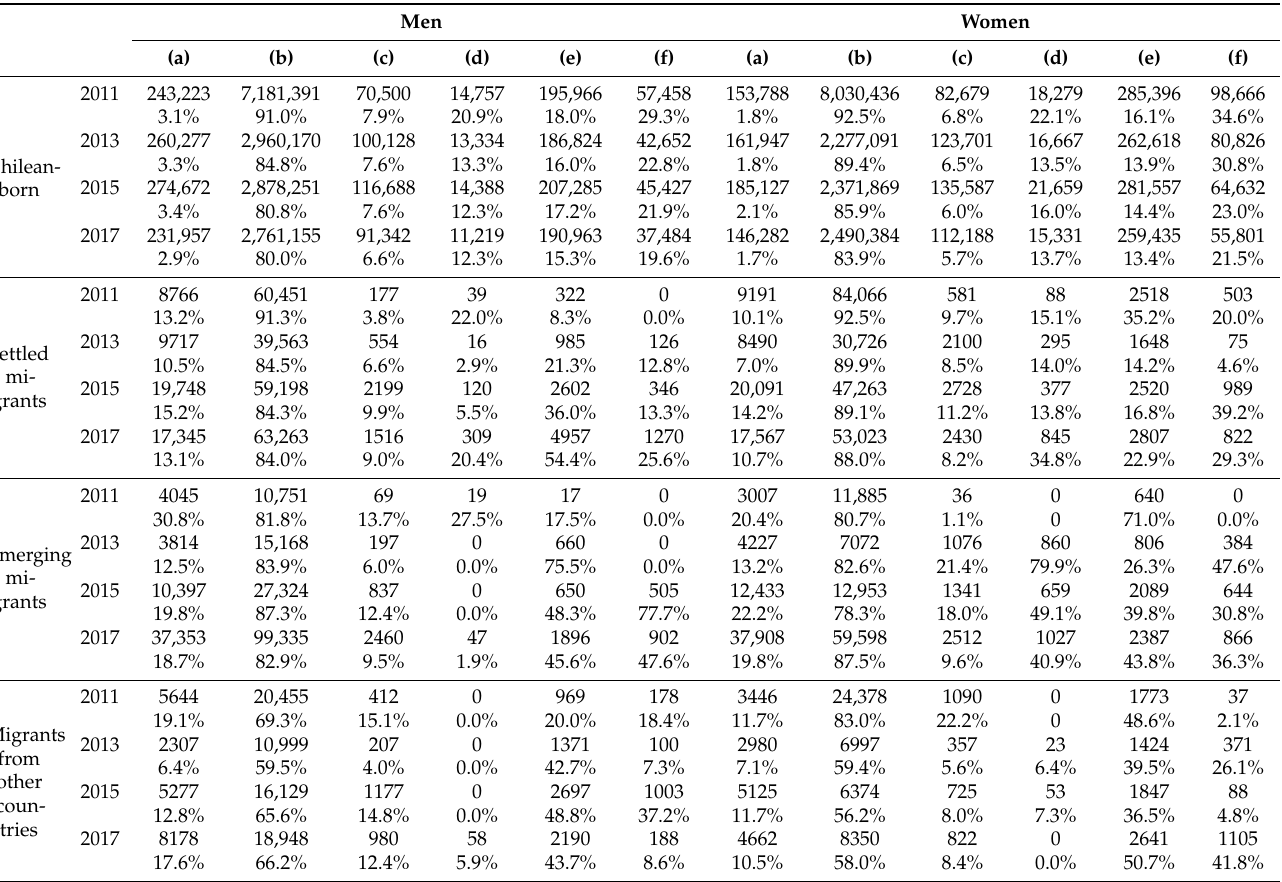
Table 3. Indicators of access and use of health care services in the Chilean-born population and immigrant population (settled, emerging, and other countries) stratified by sex. Chile